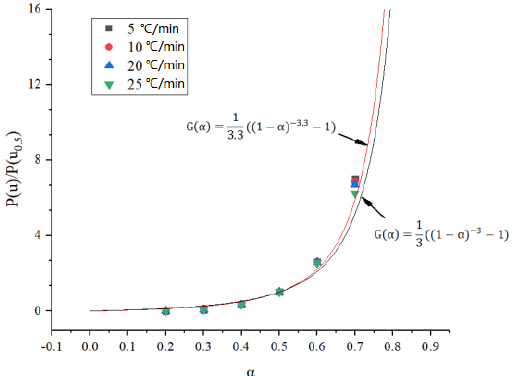
Figure 6. Fitting of the reaction mechanism function at different heating rates.